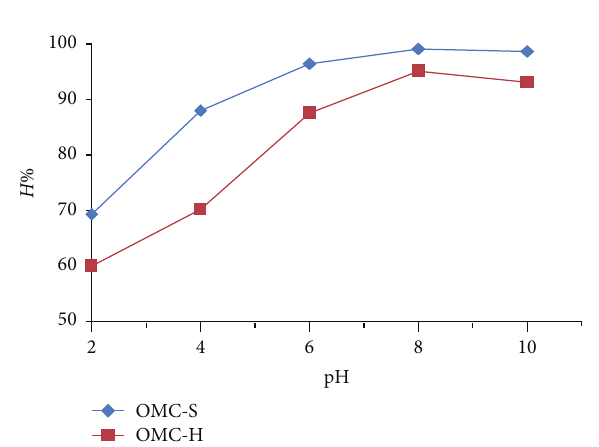
Figure 5: Effect of pH solution on the adsorption equilibrium of OMC-S and OMC-H at [MB] = 200 ppm, 𝑊/𝑉 = 0.5 g/L, and 𝑇 = 298 K.